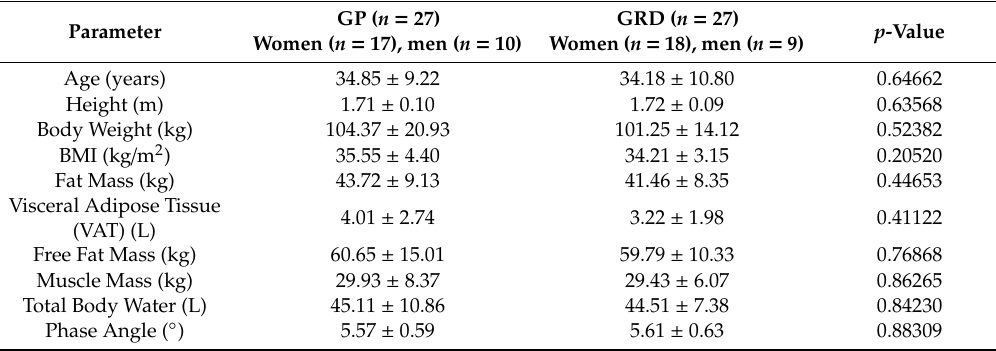
Table 1. Characteristics of the studied group before the